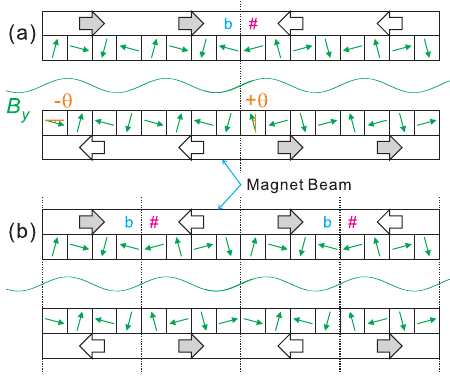
FIG. 4. Method for a fine adjustment of the magnetic force in the PCU (a) D ¼ 2 and (b) D ¼ N